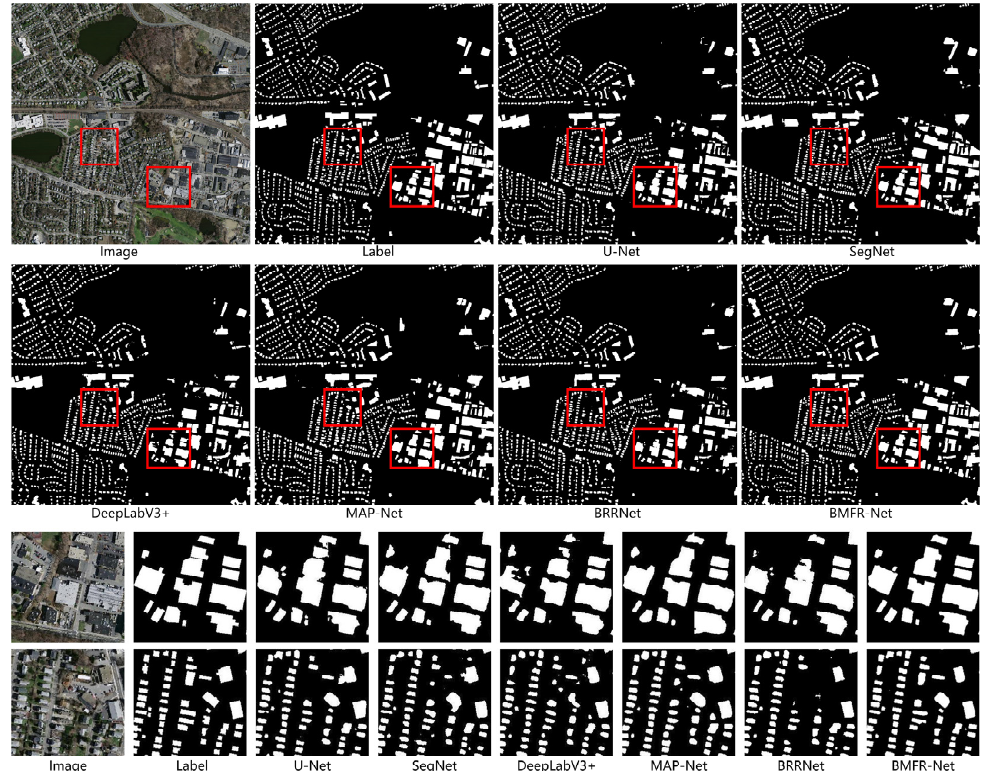
Figure 11. Extensive area building extraction results by different methods on the Massachusetts Building Dataset. The bottom column represents the corresponding partial details.